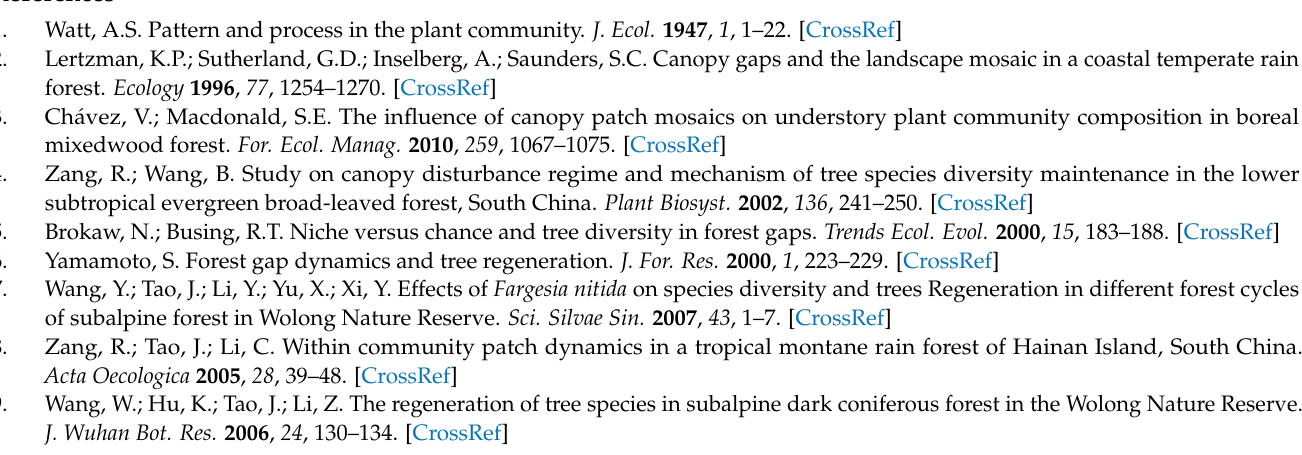
forest plots. Table S2: Basic demographics of questionnaire subjects. Table S3: Gap characteristics in 21 subalpine autumn color-leaved forest plots. Figure S1: Classification of nineteen colors. Figure S2: Proportions of gap area in five size classes in 21 subalpine autumn color-leaved forest plots. Contribution of total gap area of five different size classes to forest area in absolute percentage at each plot. Paragraph S1: The sample of the